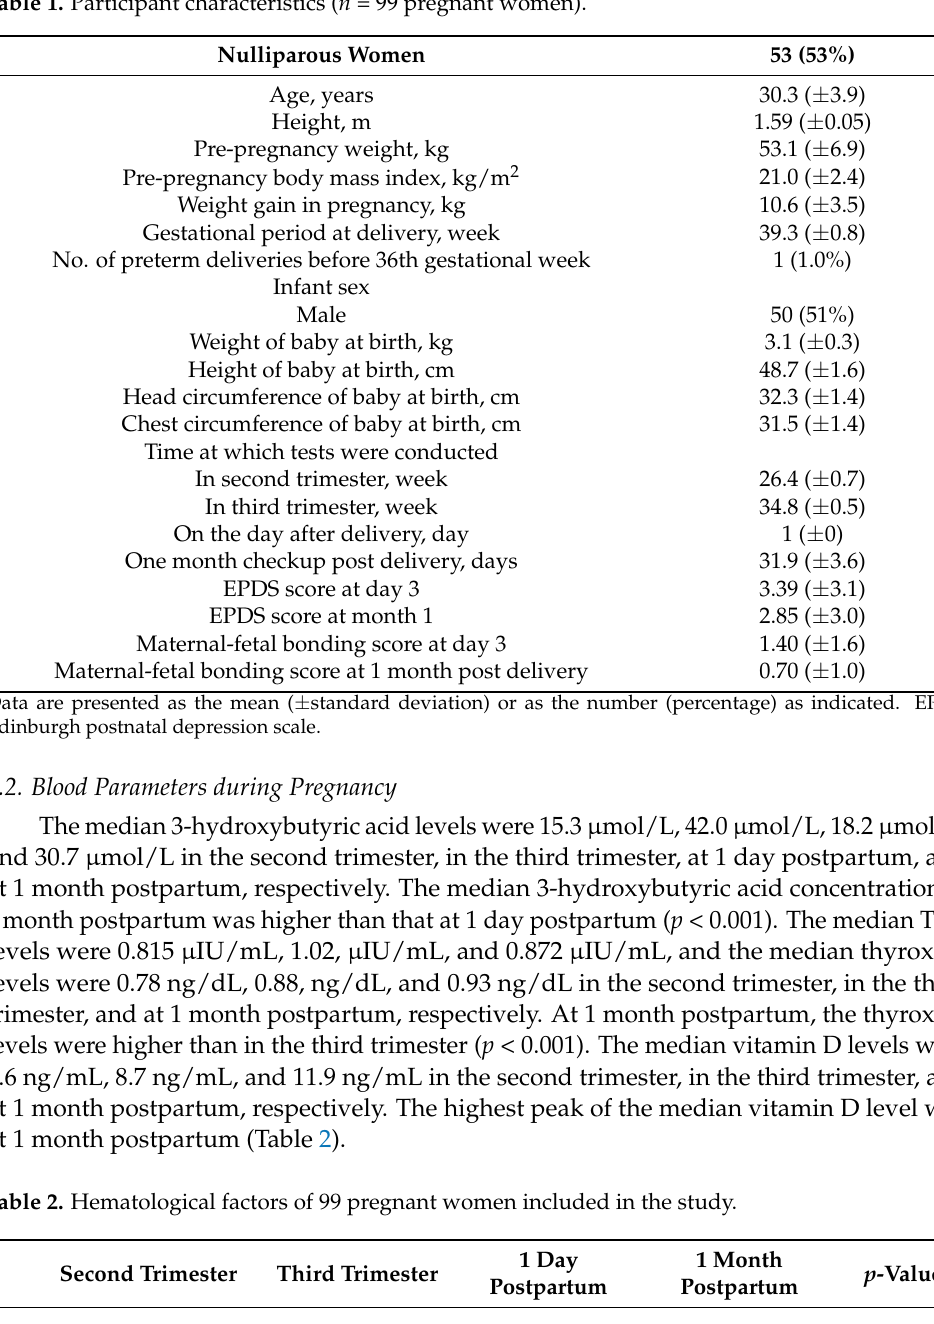
Table 1. Participant characteristics ( n = 99 pregnant women).